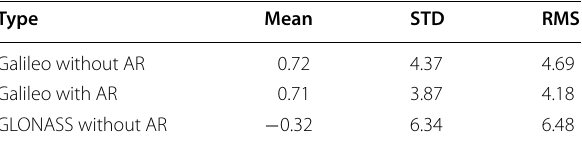
Table 5 Averaged RMS of PPP-AR error in the up ( U ), north ( N ), and east ( E ) components (unit: